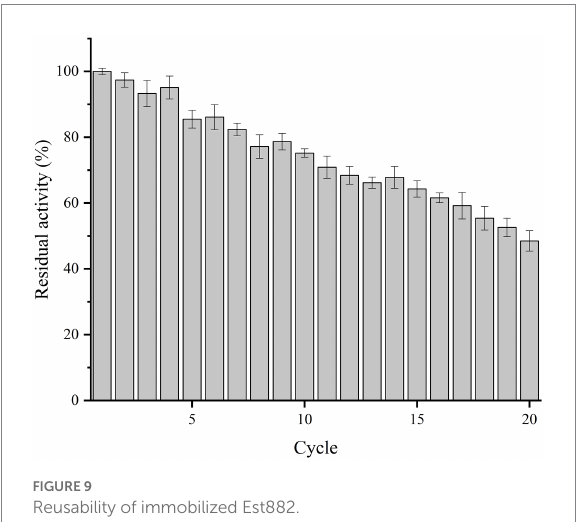
FIGURE 9 Reusability of immobilized